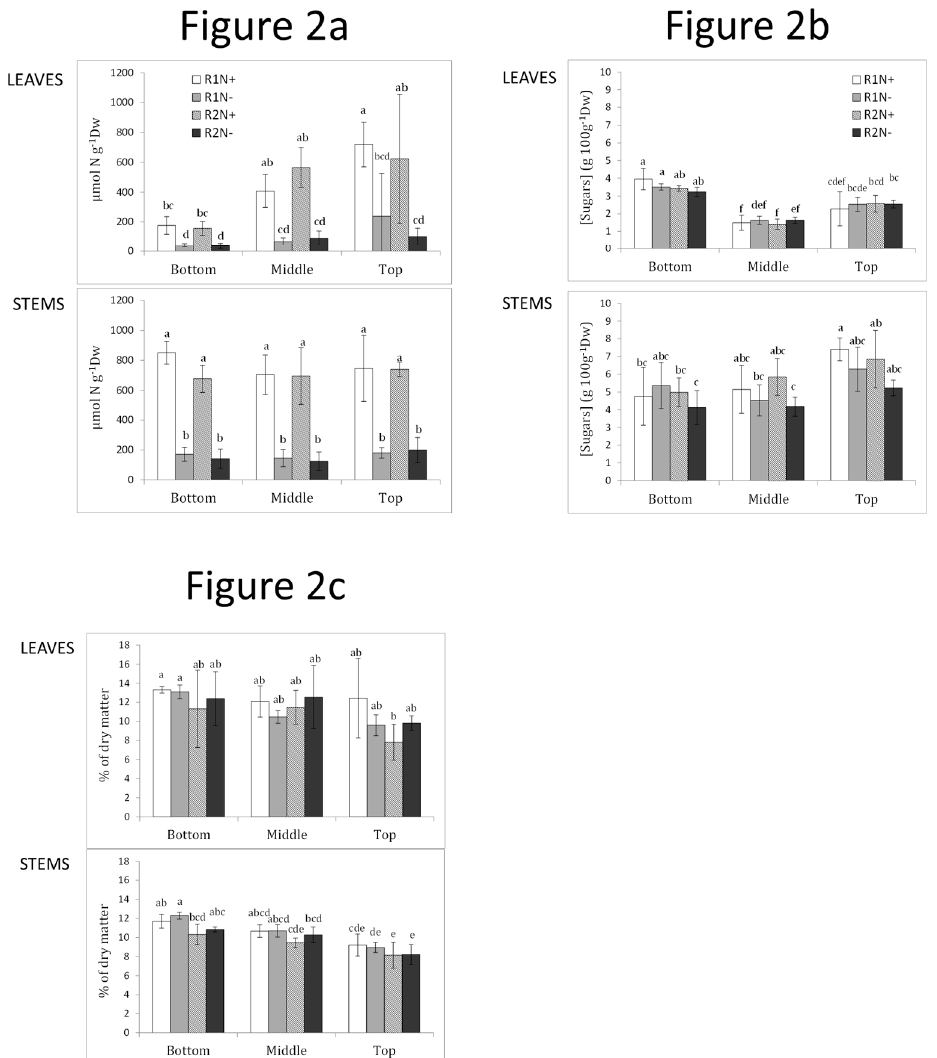
Figure 2. Nitrogen content (Figure 2a), sugar content (Figure 2b) and percentage of dry matter (Figure 2c) of leaves and stems of tomato crops R1 and R2 according to nitrogen supply. Plant material was harvested at the end of the cultivation period. R1N+ and R2N+ are represented respectively in white and dashed bars; R1N − and R2N − respectively by grey and black bars. Errors bars stand for standard deviation. Letters indicate results of statistical analysis according to Tukey’s test: different letters indicate statistical differences.